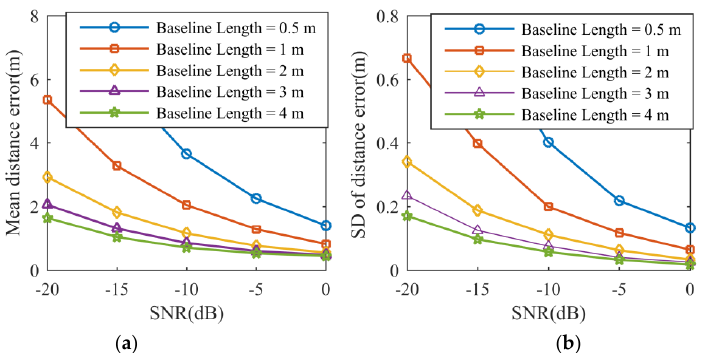
Figure 7. Simulation result. ( a ) Mean distance error. ( b ) Standard deviation of distance error.